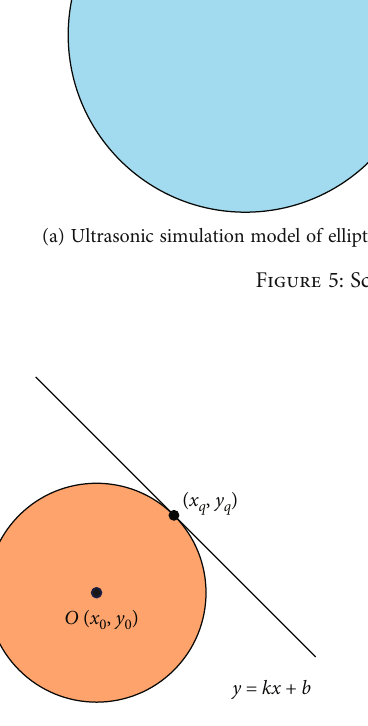
Figure 6: Schematic diagram of the tangent between a circle and a straight